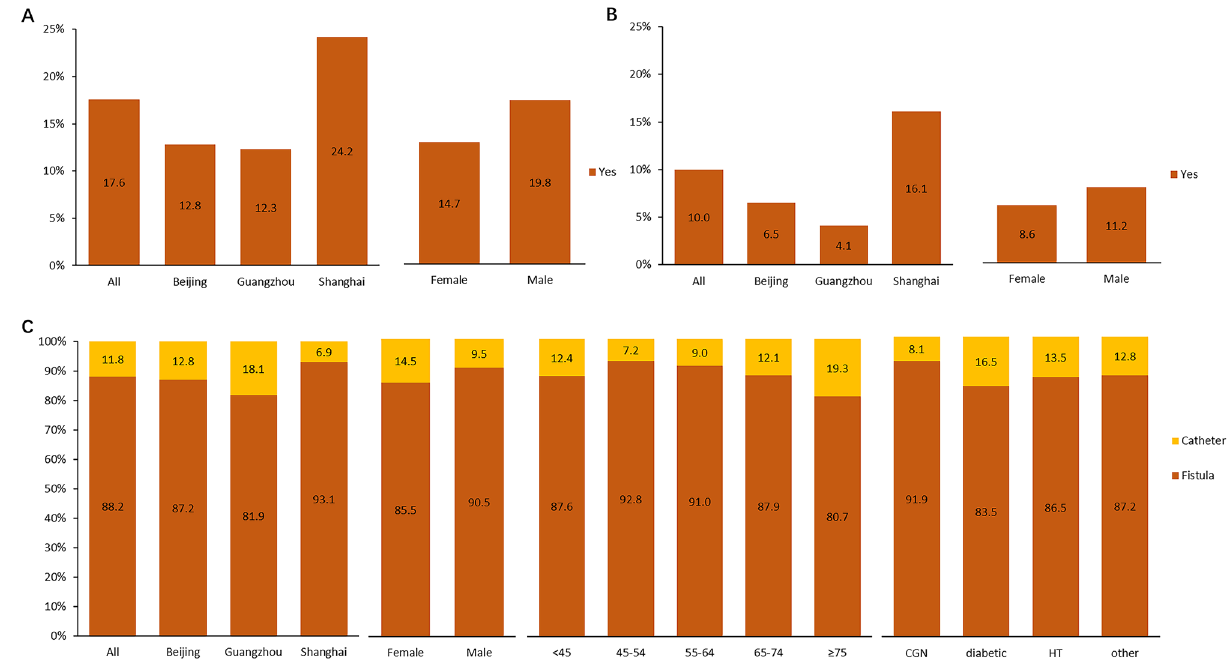
Figure 4. The distribution of hepatitis B infection, hepatitis C infection and vascular access. ( A ) The distribution of hepatitis B infection stratified by city and gender groups; ( B ) the distribution of hepatitis C infection stratified by city and gender groups; ( C ) the distribution of vascular access type stratified by city, gender, age and the primary ESKD causes